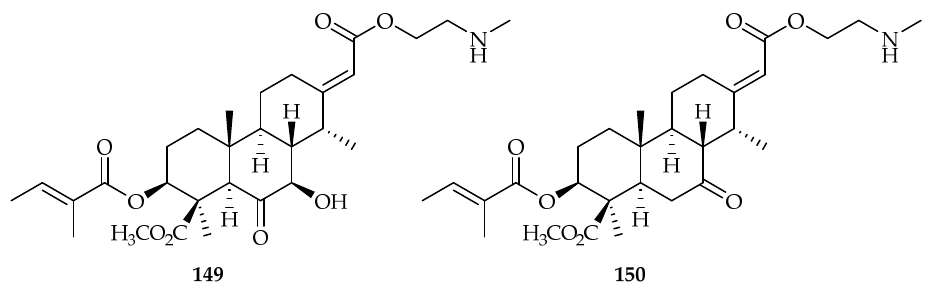
Figure 61. Structures of erythroformine A 149 and B 150